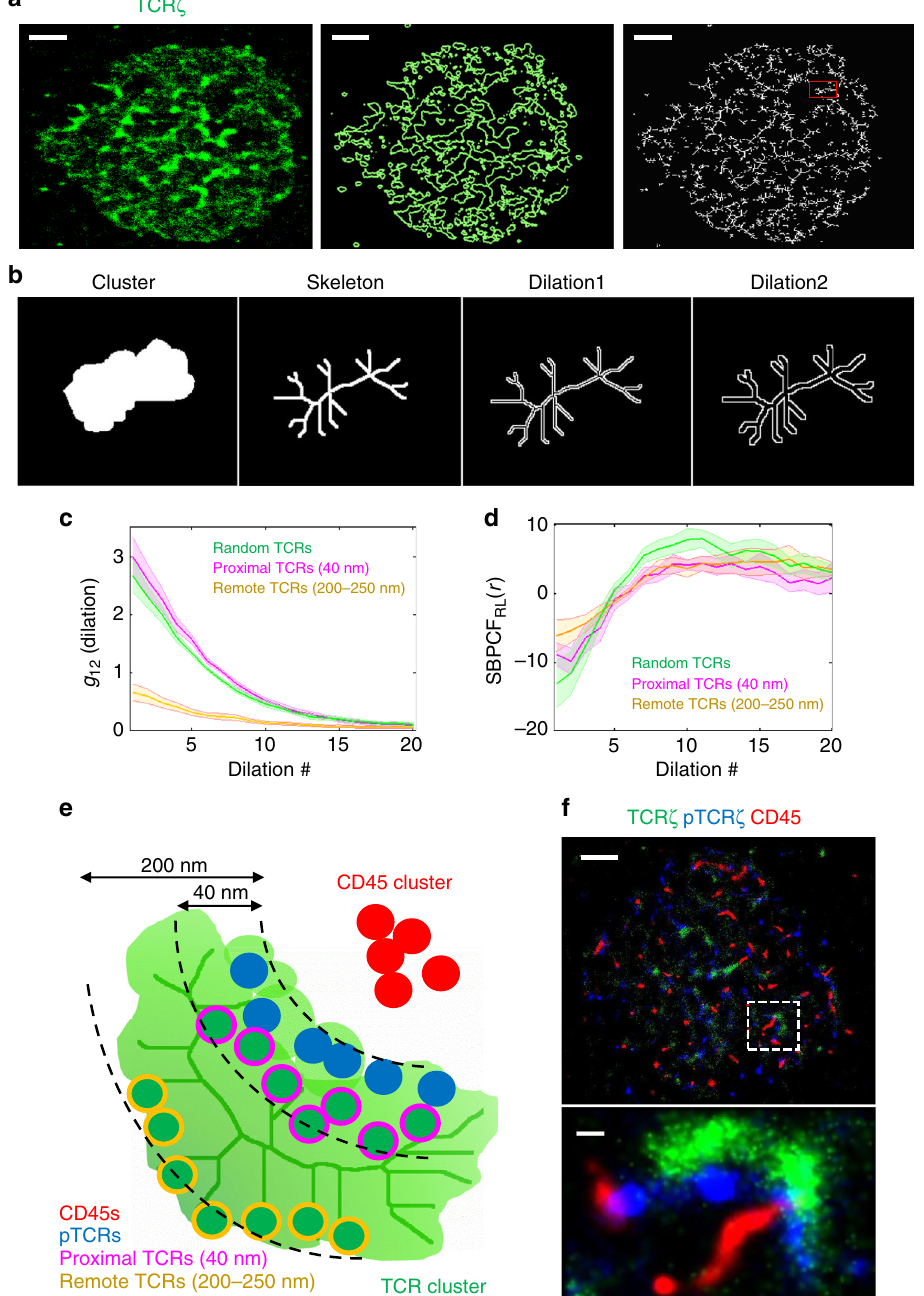
Fig. 7 Intricate positioning of TCRs and CD45 promotes localized TCR activation within clusters. a (left) Scatter plot of TCR molecules of a representative Jurkat cell fi xed after 4 min from dropping on an anti-CD3-coated coverslip. (middle) Contour map (contour level 2% of all contours) of TCR density map. (right) Skeleton map of the contour generated by Matlab morphological operations tool box, BWMorph. Scale bar 2 µ m. b The process of dilation. An isolated area (section in red in a right) is iterated with dilations. c A conditional bivariate PCF analysis adopting the dilation shapes as a basis for the spatial statistics between TCR and CD45 molecules of Jurkat cells fi xed after 4 min from dropping on anti-CD3-coated coverslip. d The conditional bivariate PCF shown in c normalized by the RL model. e Illustration of the model proposed. f A representative Jurkat cell fi xed after 4 min from dropping on an anti-CD3- coated coverslip. Scale bar 2 µ m and 200 nm in the enlarged